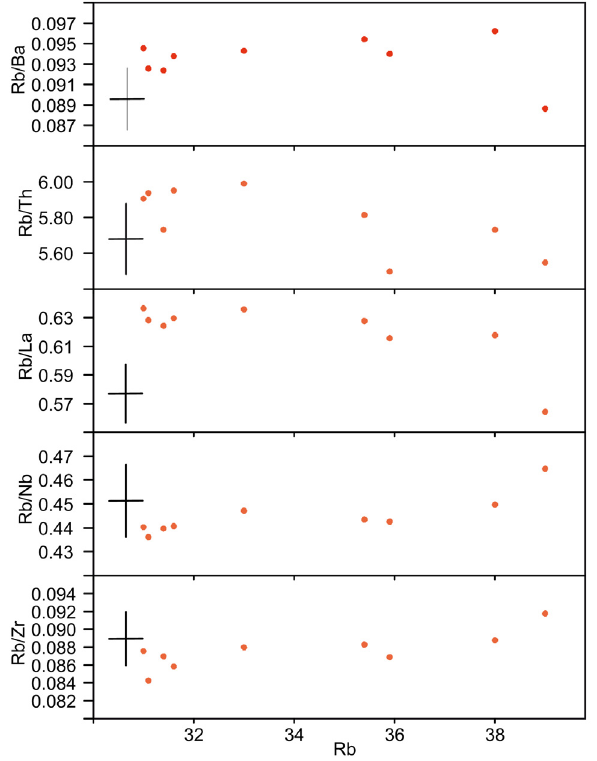
Figure 9. Variation diagrams (unit in ppm) for bulk rock Rb/Ba, Rb/Th, Rb/La, Rb/Nb and Rb/Zr ratio versus Rb during the 2011- 12 El Hierro eruption. Error bars (black crosses) represent 1